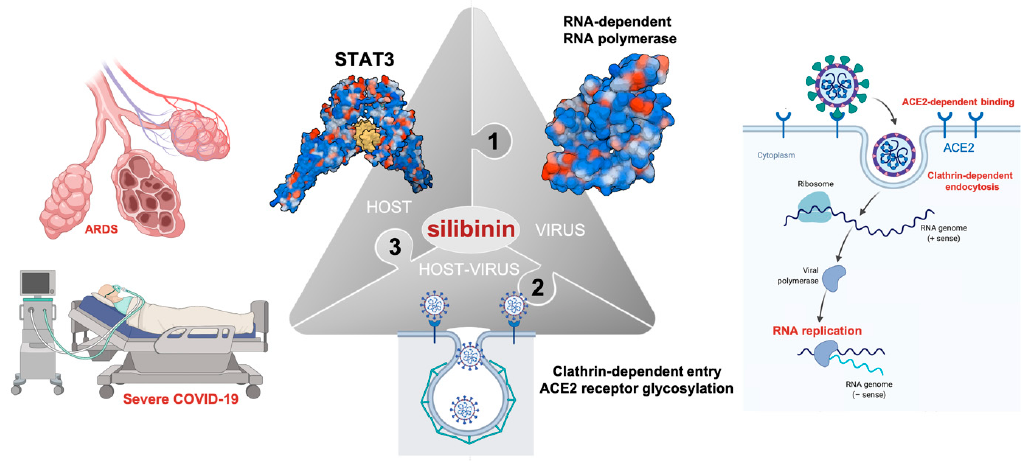
Figure 6. Silibinin: A multi-faceted approach to SARS-CoV-2 / COVID-19. The SARS-CoV-2 / COVID-19 pandemic is a current threat to human health. As the application of antiviral drugs is expected to